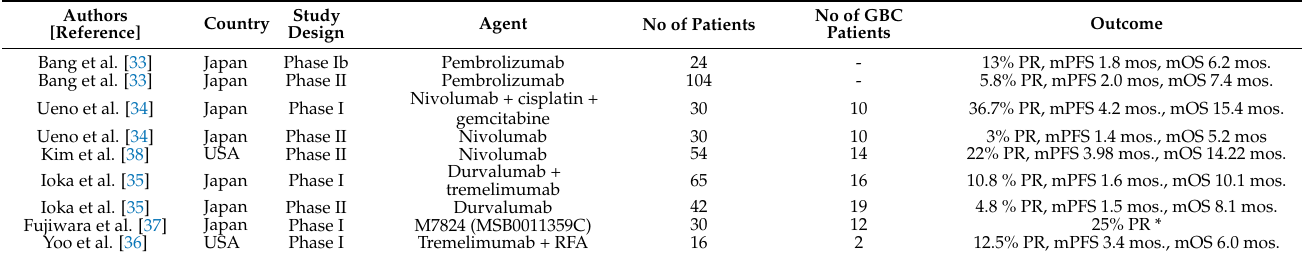
Table 5. Meta-analysis of trials on PD-1/PD-L1 inhibition in gallbladder